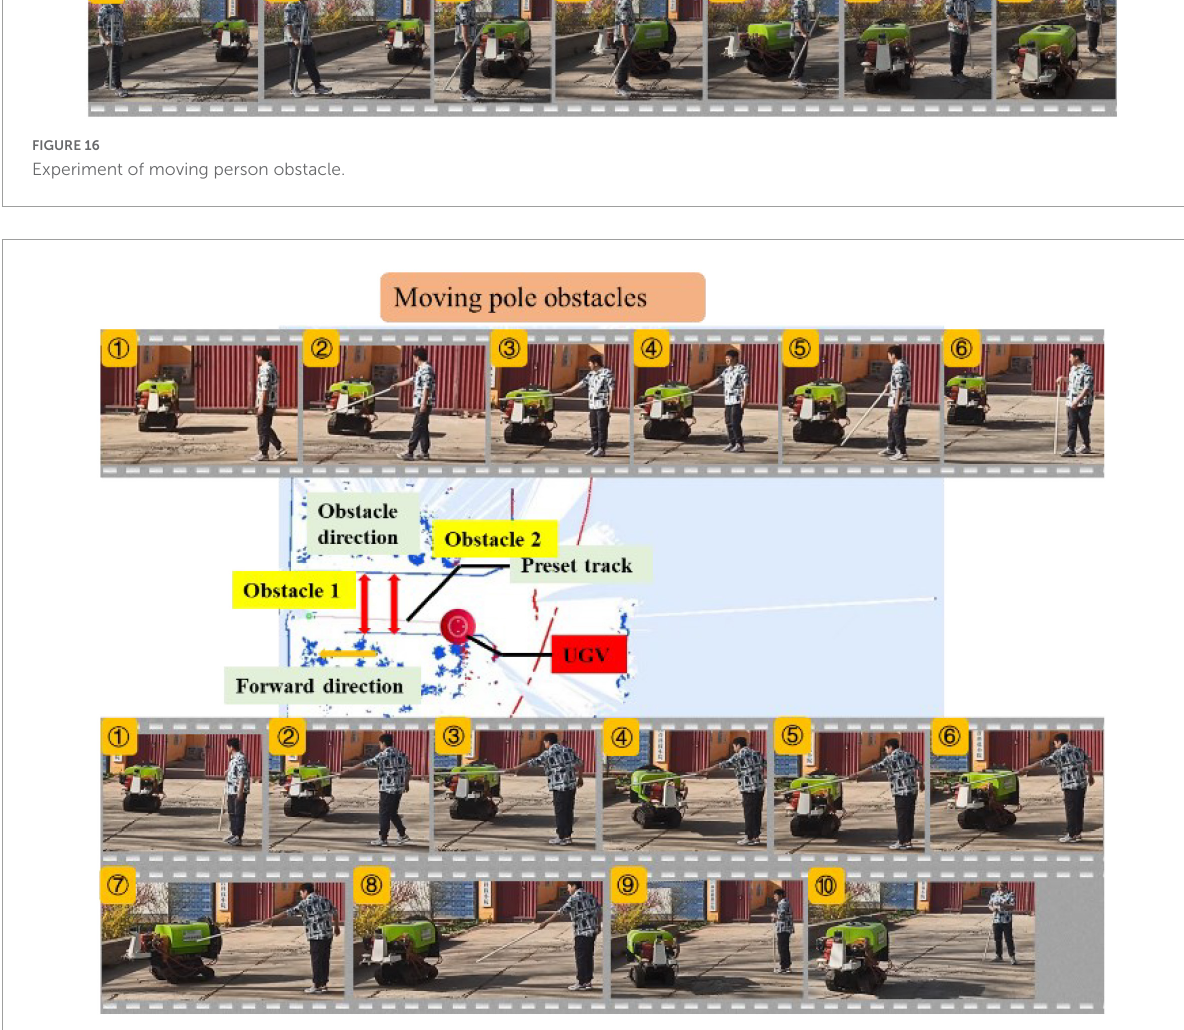
FIGURE17 Experiment of moving pole